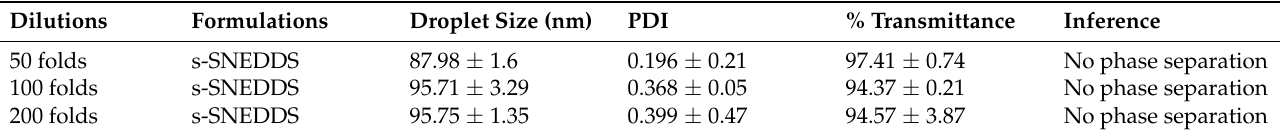
Table 2. Effect of dilution on stability of